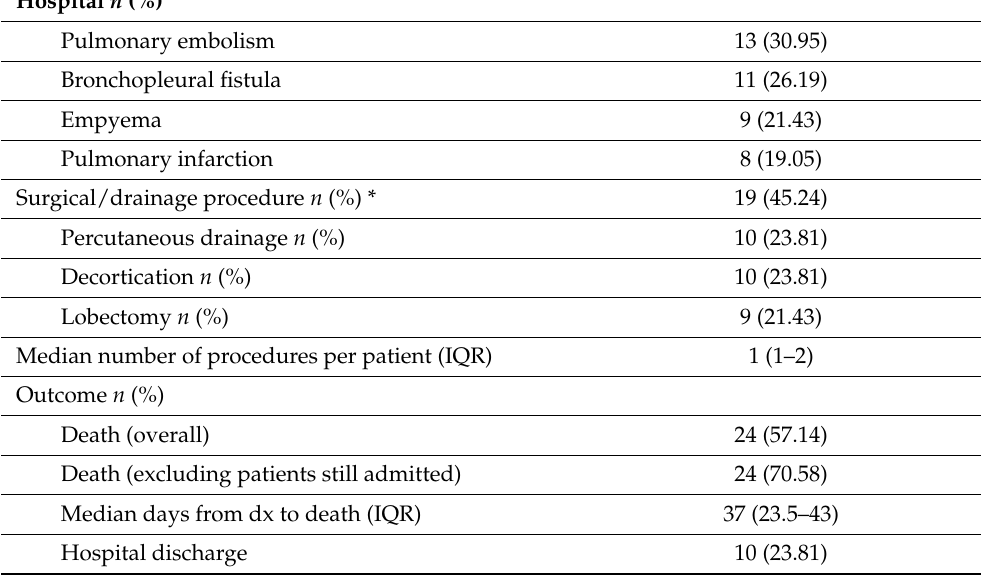
Table 1 Legend. SD: standard deviation; n : number; dx: diagnosis; IQR: interquartile range; IMV: invasive mechanical ventilation; COPD: chronic obstructive pulmonary disease; CKD: chronic kidney disease; CAD: coronary artery disease; K. pneumoniae : Klebsiella pneumoniae ; P. aeruginosa : Pseudomonas aeruginosa ; S. marcescens : Serratia marcescens ; P. mirabilis : Proteus mirabilis ; MSSA: methicillin-sensitive Staphylococcus aureus ; MRSA: methicillin-resistant Staphylococcus aureus ; B. cepacia : Burkholderia cepacia ; E. cloacae : Enterobacter cloacae ; MIC: minimum inhibitory concentration; LDH: lactate dehydrogenase; PaFiO 2 ratio of arterial oxygen partial pressure (PaO2 in mmHg) to fractional inspired oxygen (FiO2); WBC: white blood cell; CRP: C-reactive protein. * The sum may exceed 42 because each case may have had one or more of the characteristics in the